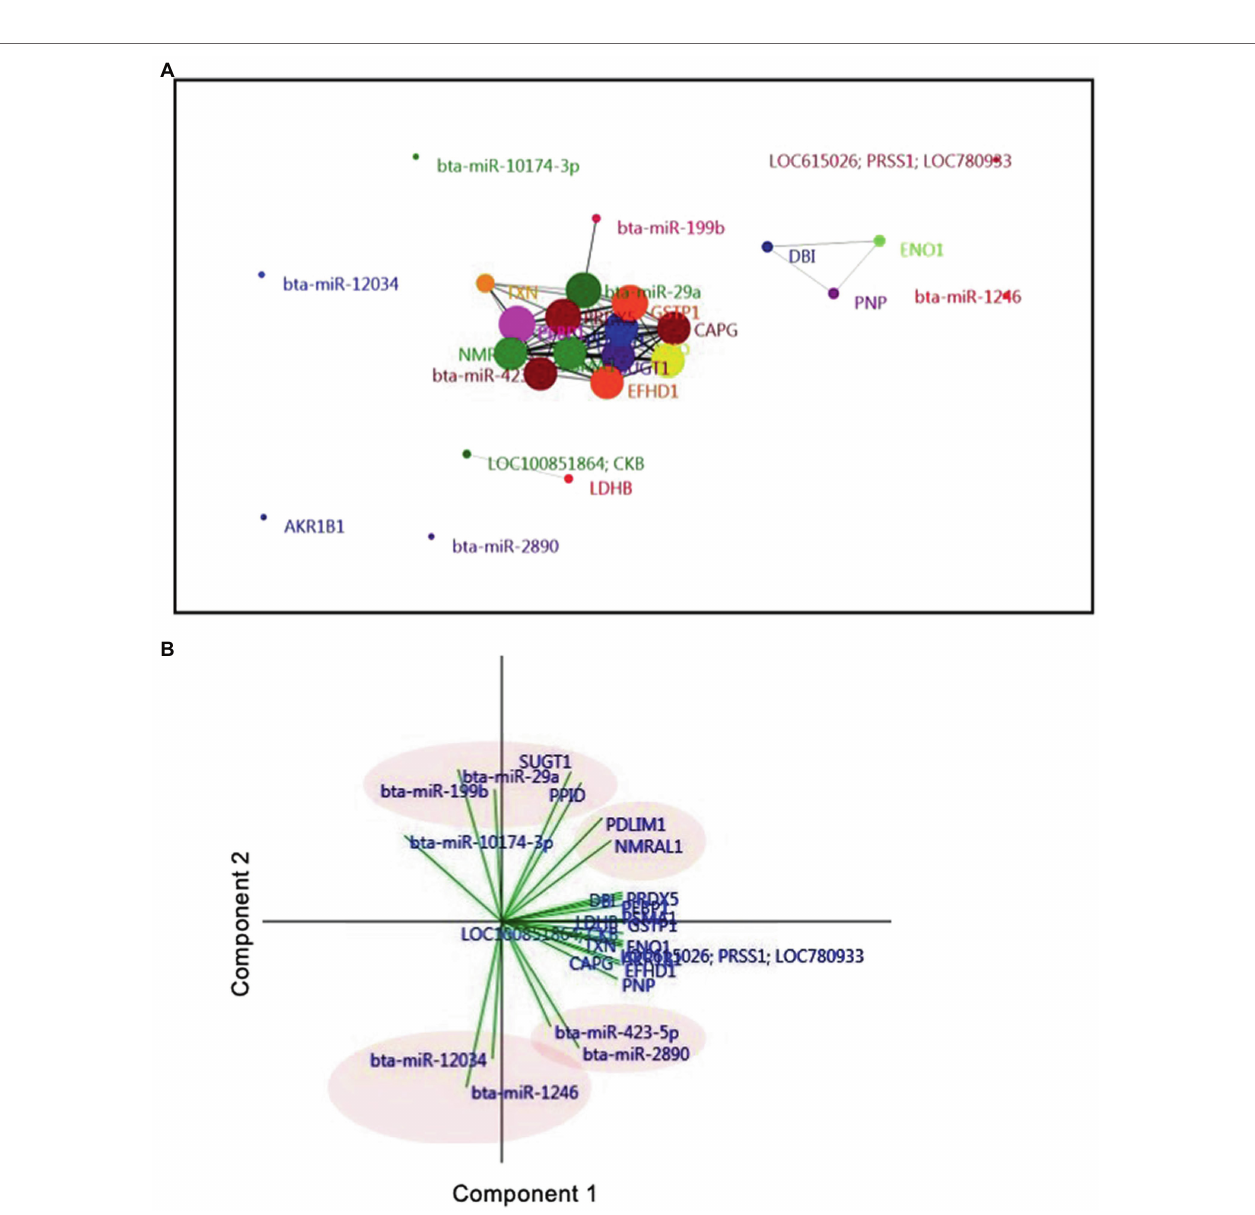
FIGURE 5 | Interaction of exosomal miRNAs and proteins in D7 UF-containing embryos. (A) Correlation-based network analysis of exosomal miRNAs and proteins in UF. Eighteen unique proteins and nine differentially expressed miRNAs in UF of cows were mapped to a network analysis. Network analysis and visualization were carried out using the PAST and Fruchterman-Reingold algorithm as a force-directed layout algorithm. The Pearson correlation thresholds of 99% were chosen to assess the relationships between edges and nodes. Nodes are proteins and miRNAs. Edges are the interactions of all variables. The size of the nodes and edges refers to the coefficient of clustering and the coefficient of correlation, respectively. Small nodes and thin edges refer to small values. (B) Biplot generated from the PCA of factors, including 18 unique proteins and nine differentially expressed miRNAs found in the UF of cows. Vectors with close angles (<45 ° ) indicate a strong correlation, perpendicular vectors indicate no correlation, and vectors in opposite directions (approaching 180 ° ) indicate a negative